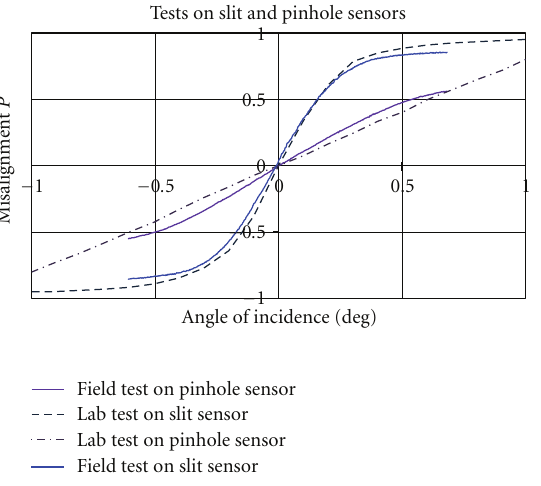
Figure 16: Laboratory and field tests for both sensors. Figure 17: Simulated and measured data for pinhole